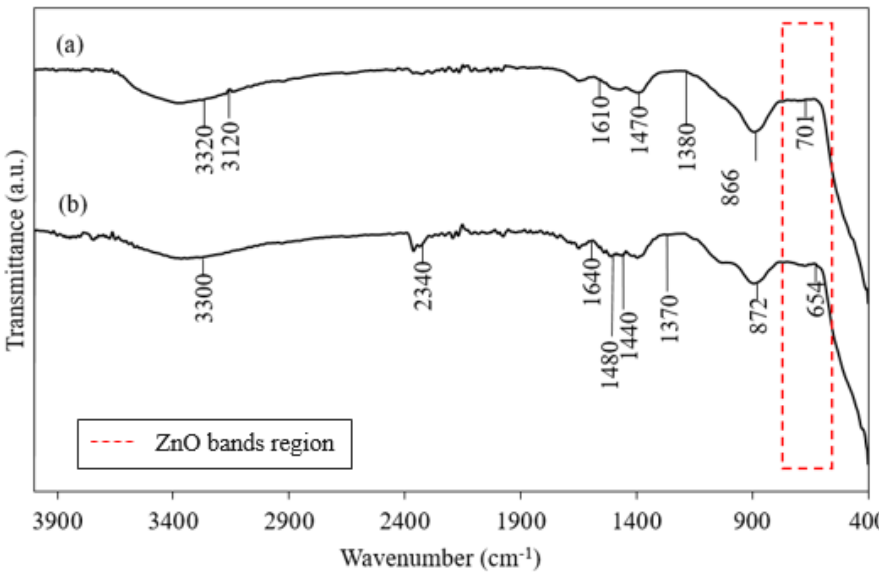
Figure 1. FTIR spectrum of synthesized ZnO NPs prepared ( a ) with heating (60 °C) and ( b ) without heating (28 °C).